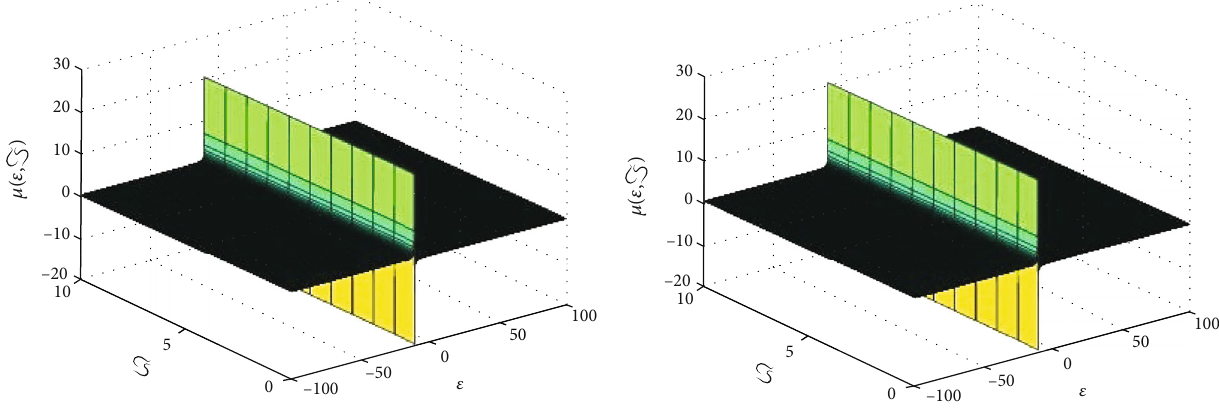
Figure 2: Exact and approximate solution of μ ð ε , I Þ at ϑ = 1 .